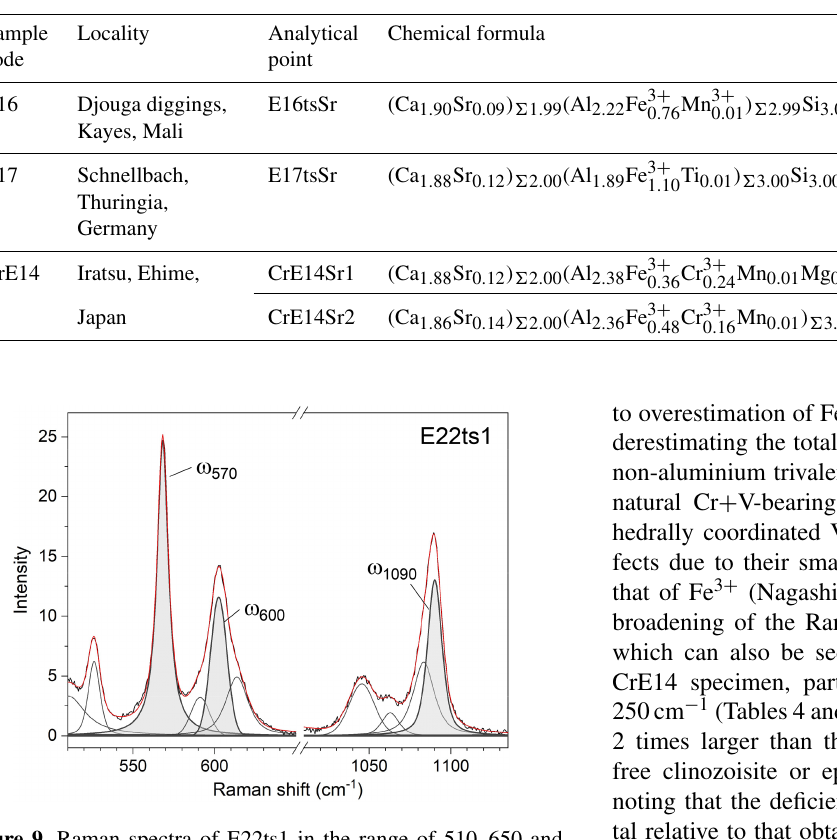
Figure 9. Raman spectra of E22ts1 in the range of 510–650 and 1010–1135cm − 1 along with the fitting pseudo-Voigt